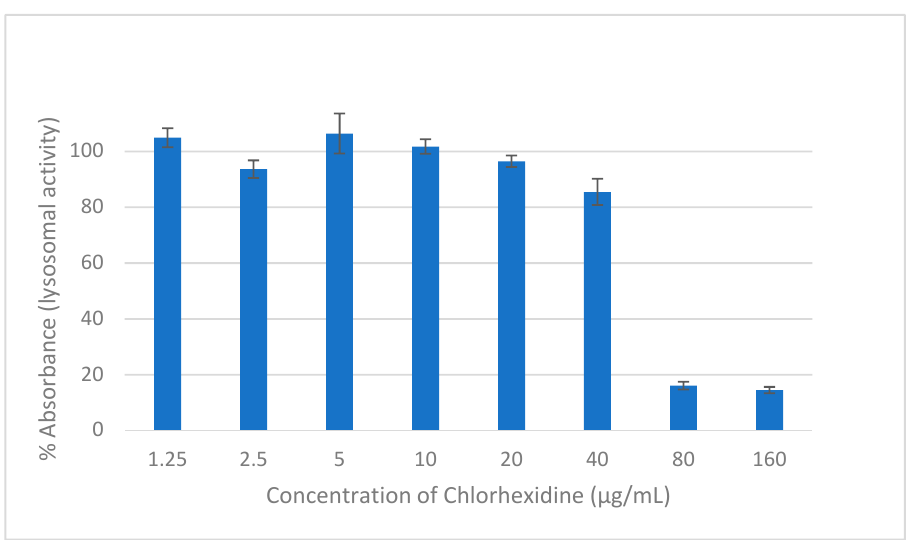
Figure 2. The effect on the viability of HEK293 cells of two hours of exposure to different concentrations of CHD measured using NR assay. Data are expressed as mean percentages ± SE, n = 9.